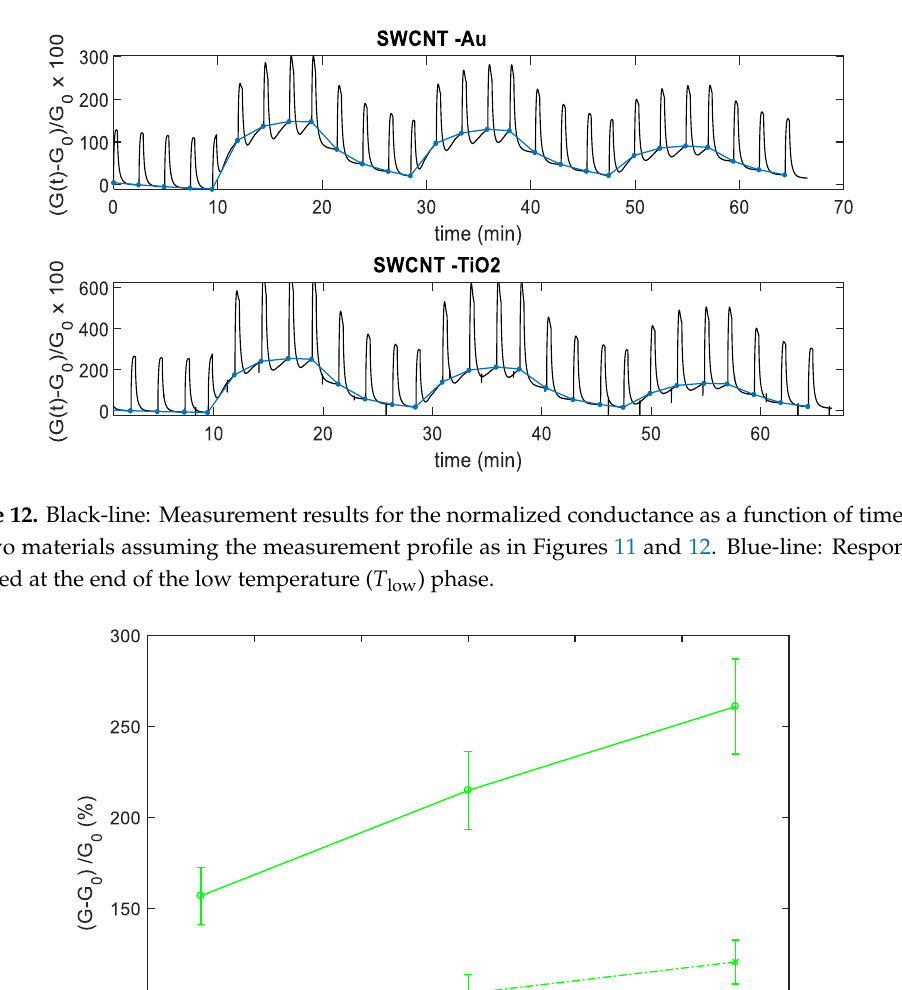
Figure 12. Black-line: Measurement results for the normalized conductance as a function of time for the two materials assuming the measurement profile as in Figures 11 and 12. Blue-line: Responses sampled at the end of the low temperature ( T low ) phase.